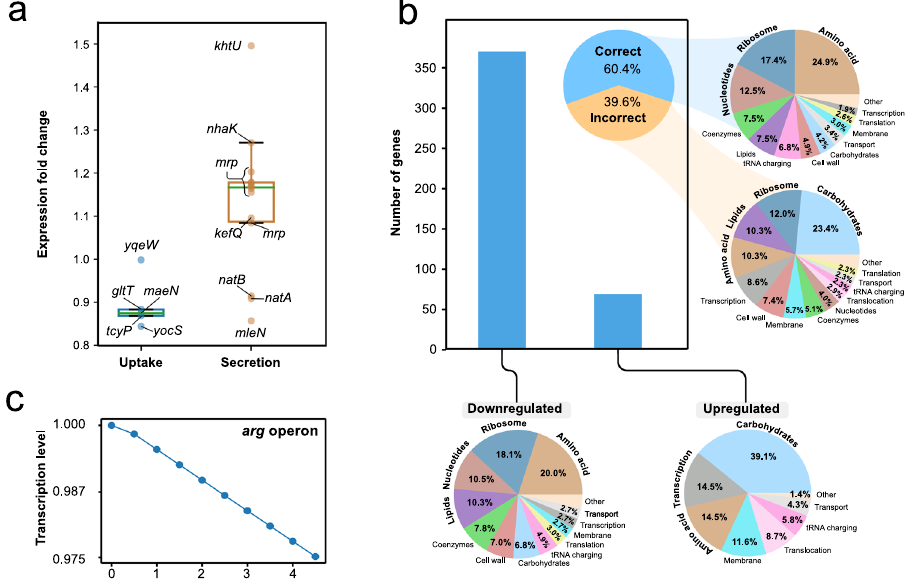
Fig. 3 Prediction of differential expression under salt stress. a Fold change in transcription of sodium exporters and importers, as reported in the RNASeq dataset available 45 . b Accuracy of differential expression prediction under salt stress. Breakdowns of metabolic functions of differentially regulated reactions are shown in the pie charts. c Relative transcription level of the arg operon under increasing sodium uptake rates, from 0 to 4 mmolgDW (cid:1) 1 h (cid:1) 1